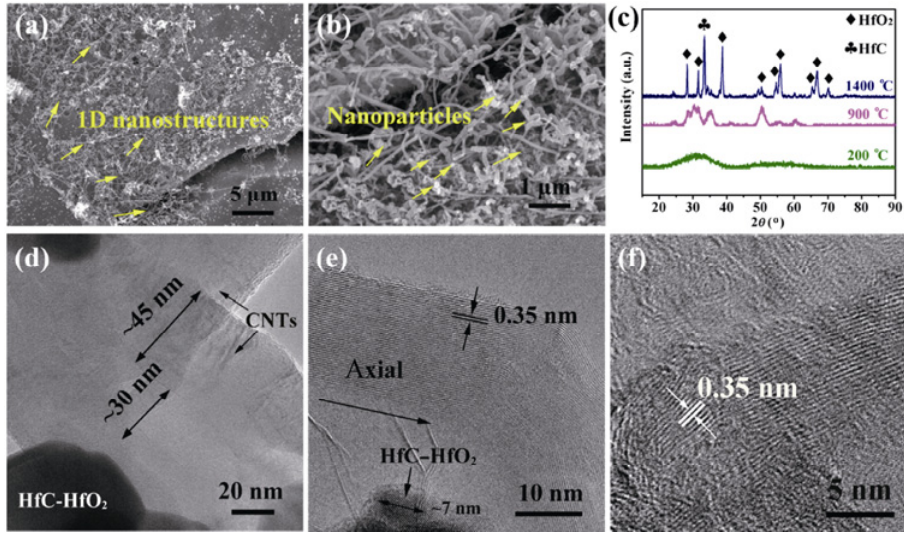
Fig. 6 Microstructures of synthesized CNT/HfC–HfO 2 . (a, b) SEM images; (c) XRD patterns; and (d–f) TEM